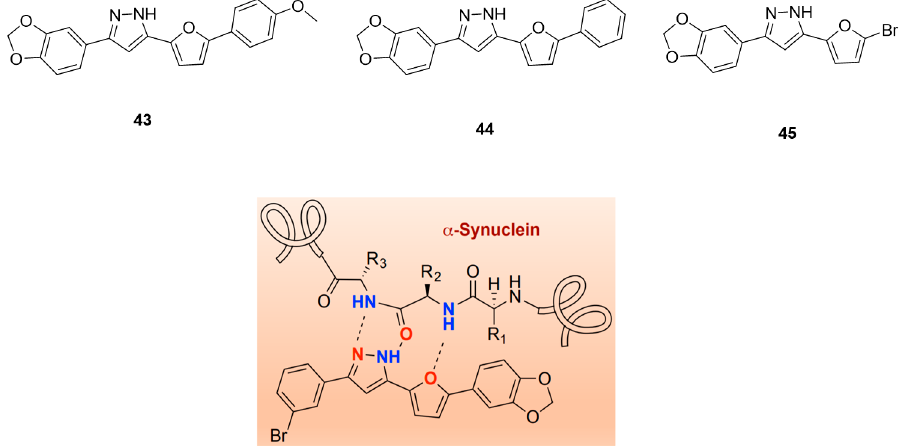
Figure 20. Chemical structures of furan-2-yl-1H-pyrazoles derivatives 43 , 44 , and 45 and proposed binding scheme of a peptide backbone with a furan-2-yl-1H-pyrazole with highlighted HBD and HBA features (reprinted with permission from [130]. Copyright 2020 American Chemical Society).